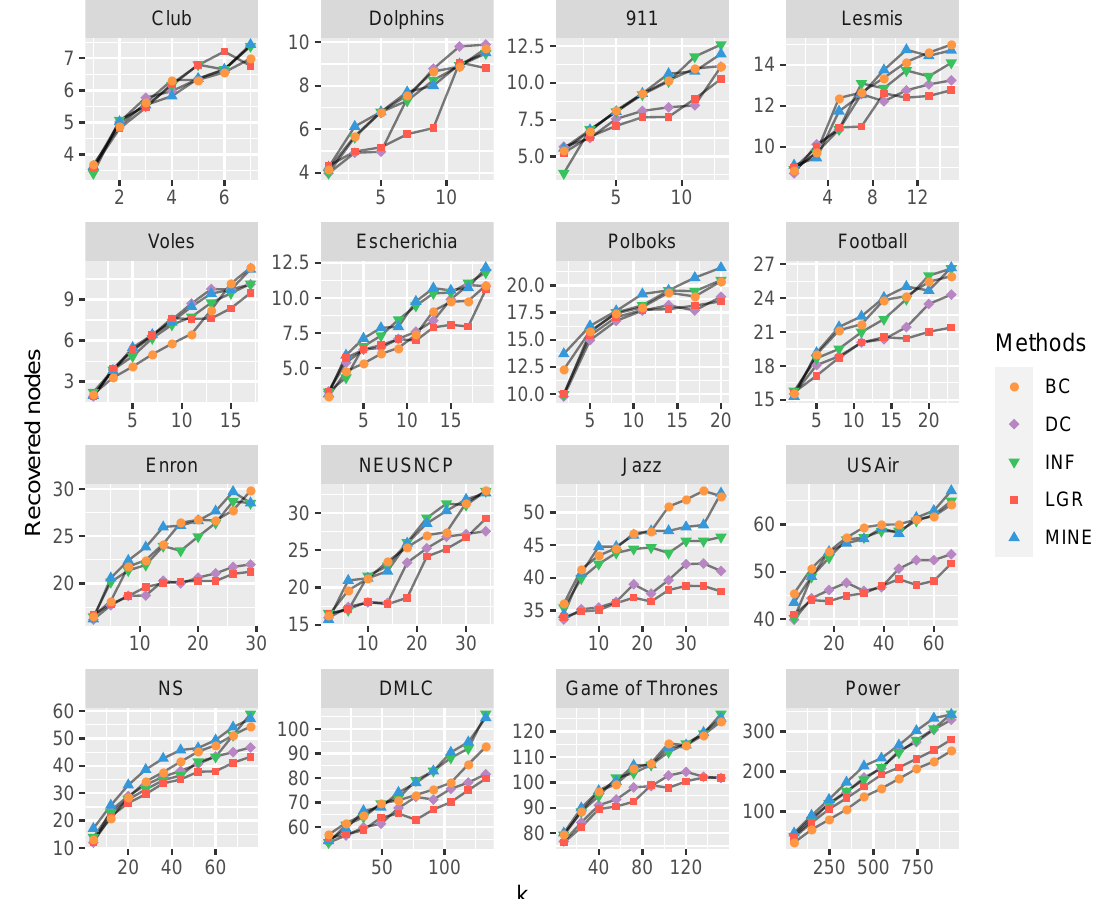
Figure 4. The comparison of recovered nodes with varying k (from 0 to 20 percent of total nodes) on 16 monolayer networks. The proposed MINE algorithm (marked with blue triangles) shows superiority to the competitors on Polbooks, Enron, NS, DMLC, Game of Thrones and Power datasets. While on the Jazz dataset, the MINE algorithm is second to BC (marked with orange circles) when k is in the range of [ 26,34 ] , while MINE achieves more recovered nodes (averaged 52.9888) than that of BC (averaged 52.5331) when k is set as 38 (i.e., twenty percent of the number of nodes in the Jazz dataset). The performance of each measure is evaluated by the height of each curve. As shown